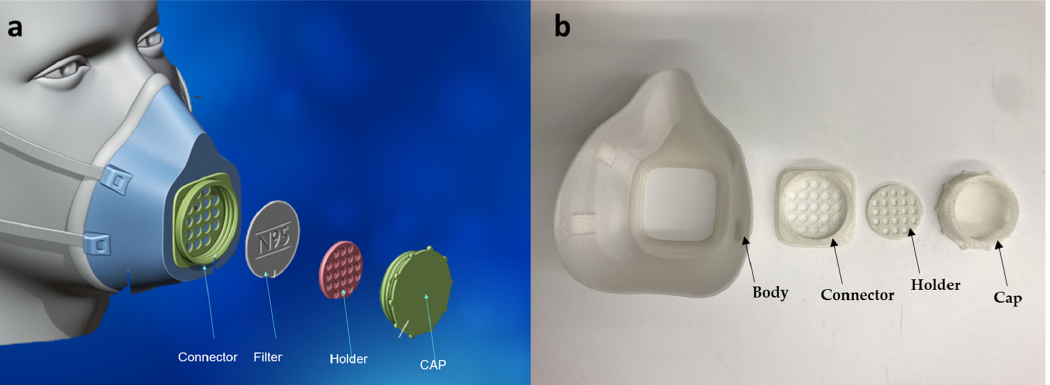
Figure 7. The respirator mask: ( a ) 3D model; ( b ) printed mask displaying the permanent shape (before molding).